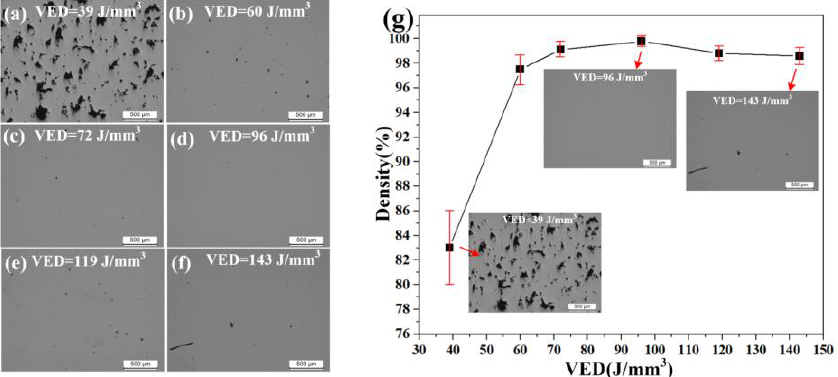
Figure 3. ( a – f ) Surface morphology at different VEDs from 39 to 143 J · mm − 3 . ( g ) Variation of density and micro-pores at different VEDs.